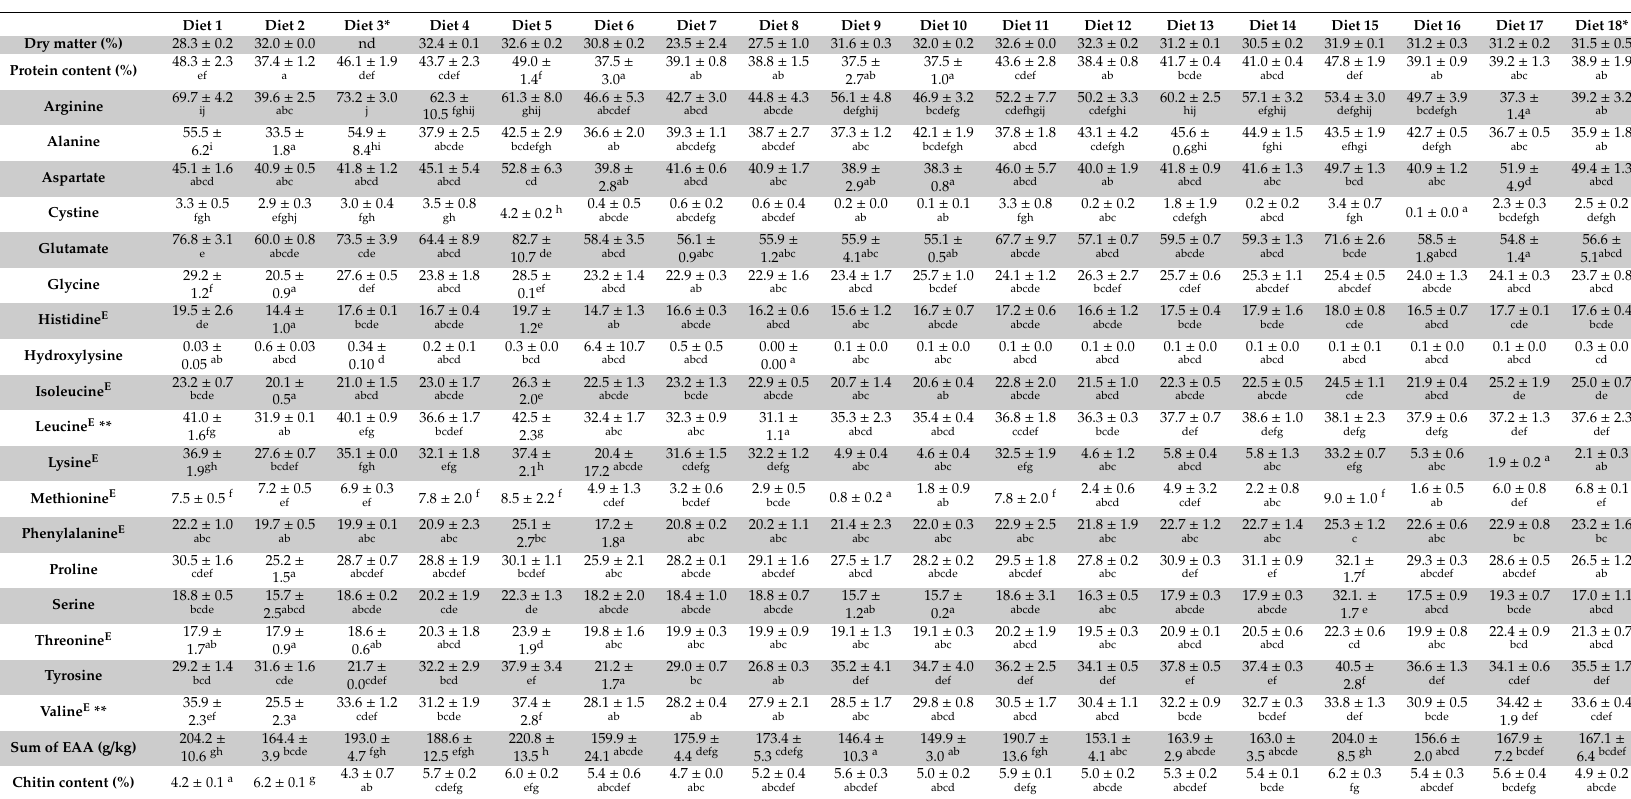
Table A4. Dry matter (%), protein content (%), amino acid profile (g / kg), sum of the essential amino acids (g / kg) and chitin content (%) of larvae on dry matter basis (mean ± SD), E essential amino acids for humans, * analysis performed in duplicate, nd: not determined, ** ANOVA analysis followed by Tukey post-hoc (letters in superscript), others were analyzed by